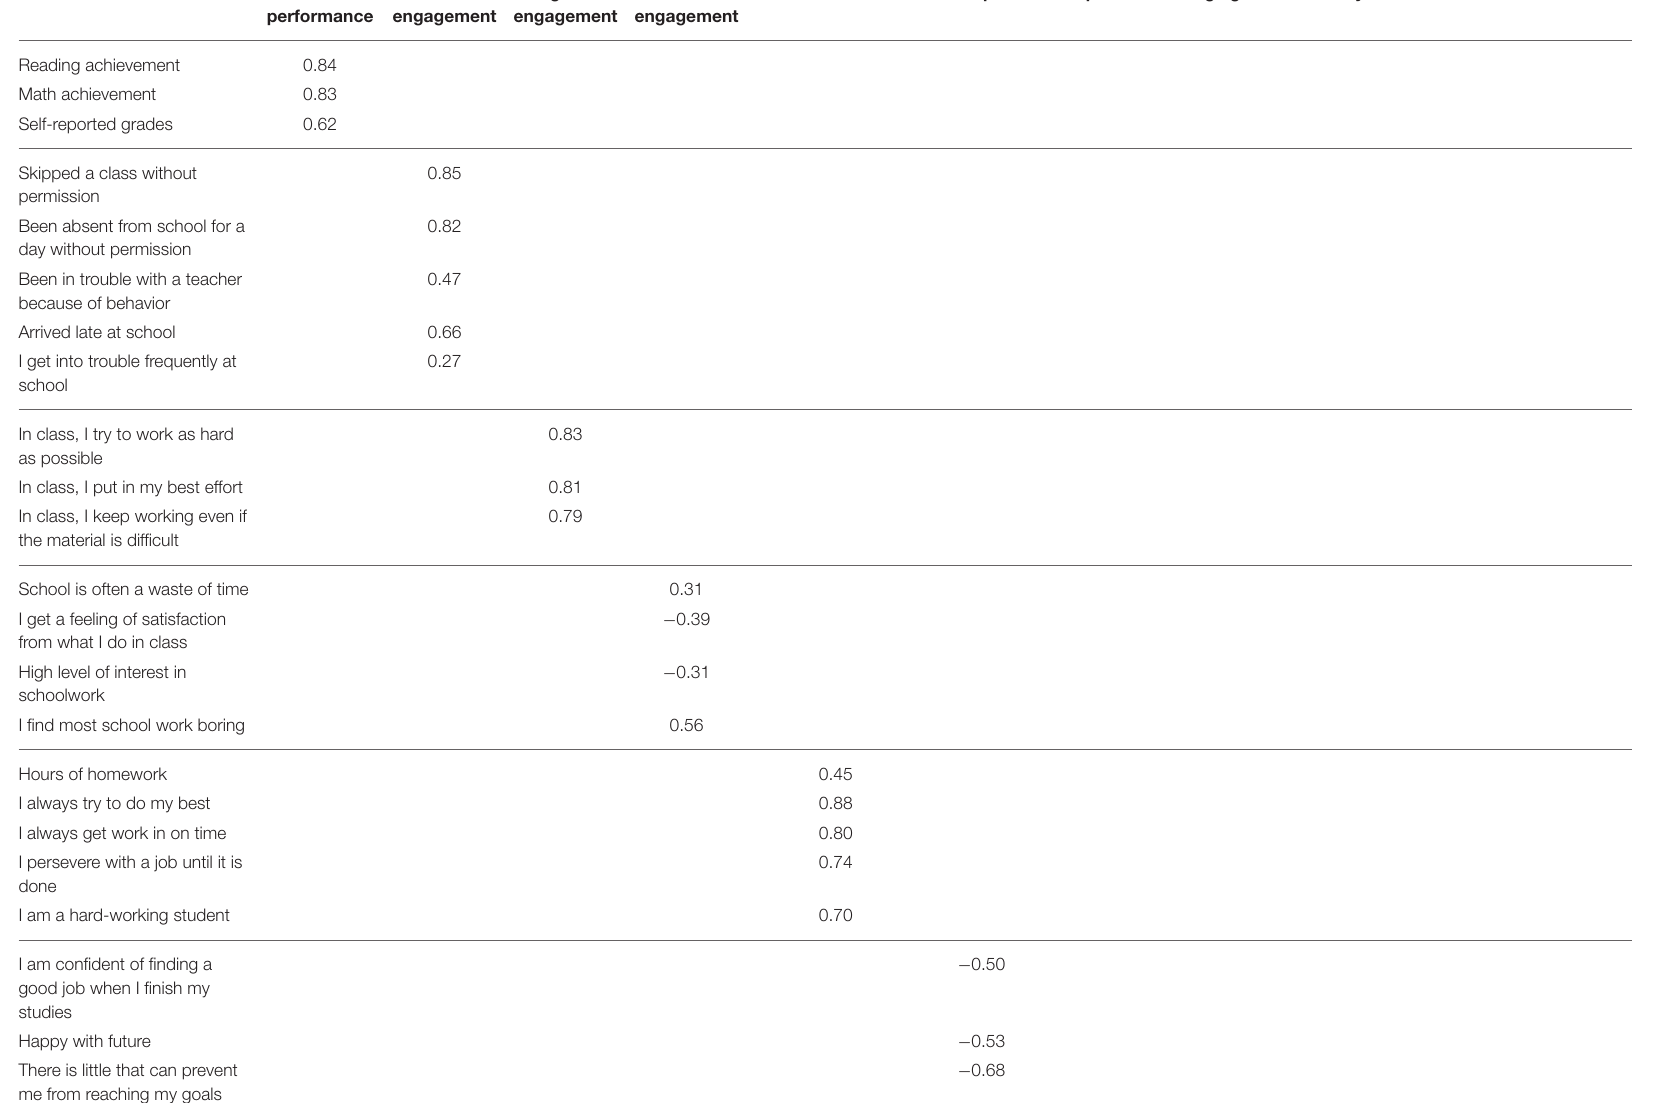
TABLE 2 | Principal component item loadings for ISCY measure models. Items Academic